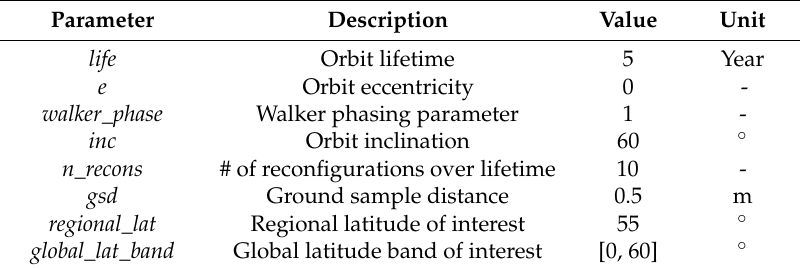
Table 4. Parameters used in ReCon